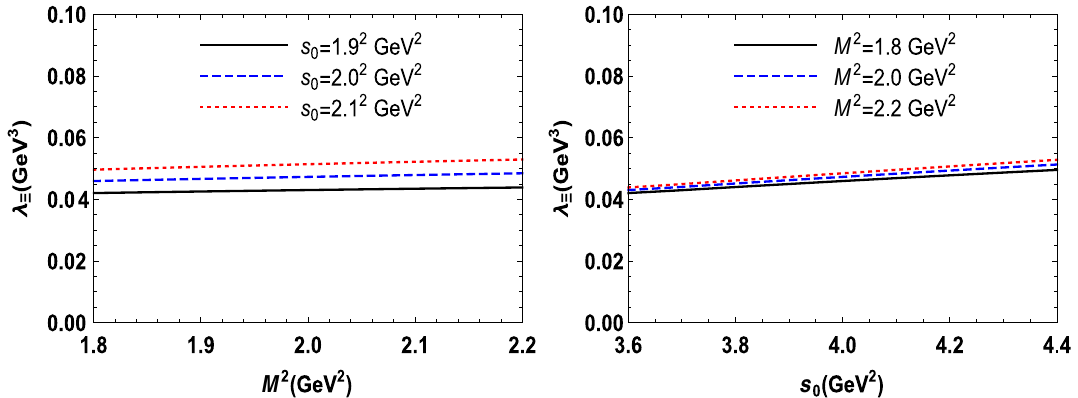
Fig. 2 The rediue of the (cid:2) baryon as a function of the Borel parameter M 2 at chosen values of s 0 (left panel), and as a function of the continuum threshold s 0 at fixed M 2 (right panel) with β = 0 . 7